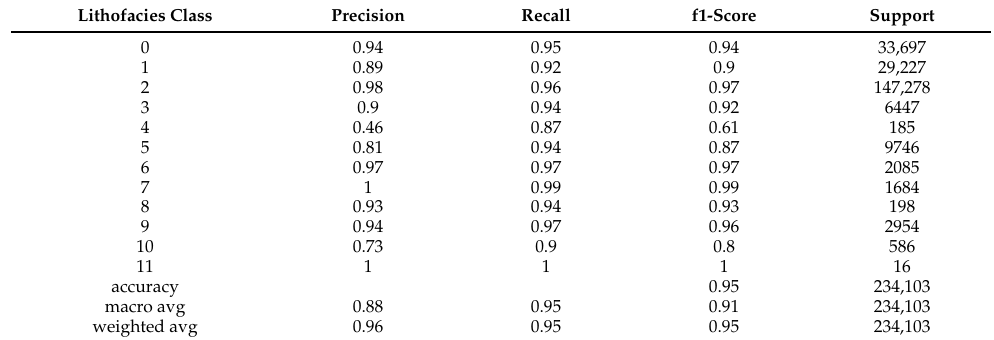
Table 7. Classification report of